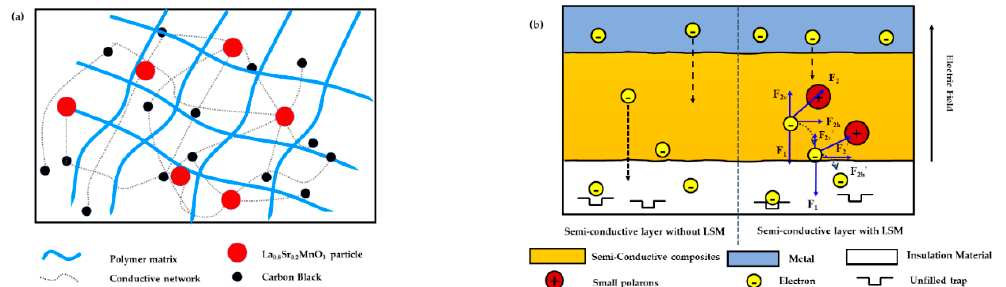
Figure 2. Schematic diagram of research idea. ( a ) Conductive network of the semi-conductive layer with La 0.8 Sr 0.2 MnO 3 (LSM); ( b ) electrons moving path in the semi-conductive layer.